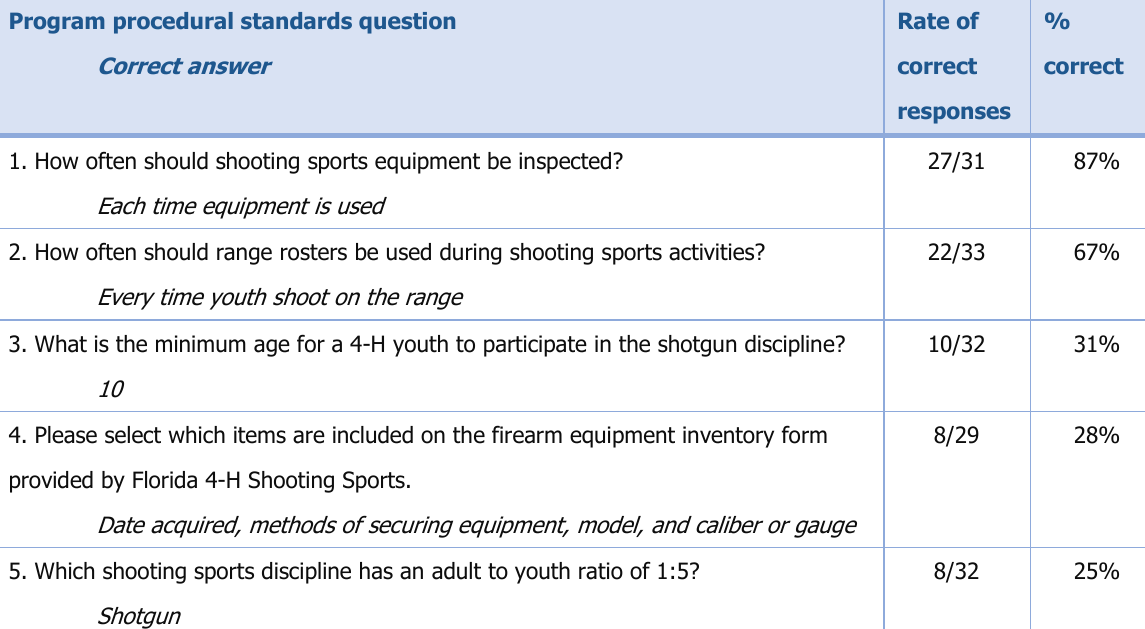
Table 3. Assessment of Respondents’ Knowledge of Program Procedural